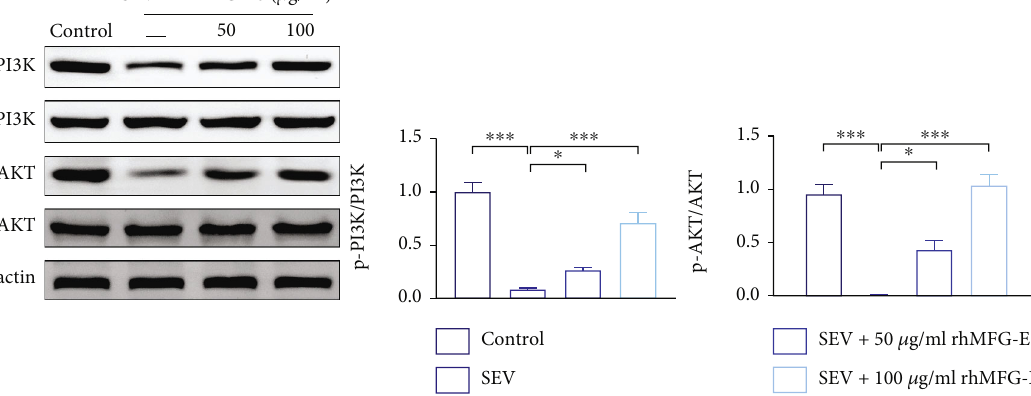
Figure 5: The study of the mechanism of CA on PI3K/AKT in the cellular induced by sevo fl urane. The protein expression of p-PI3K, PI3K, p-AKT, and AKT was detected by WB. ∗ p < 0 : 005 , ∗∗ p < 0 : 001 , ∗∗∗ p < 0 : 0001